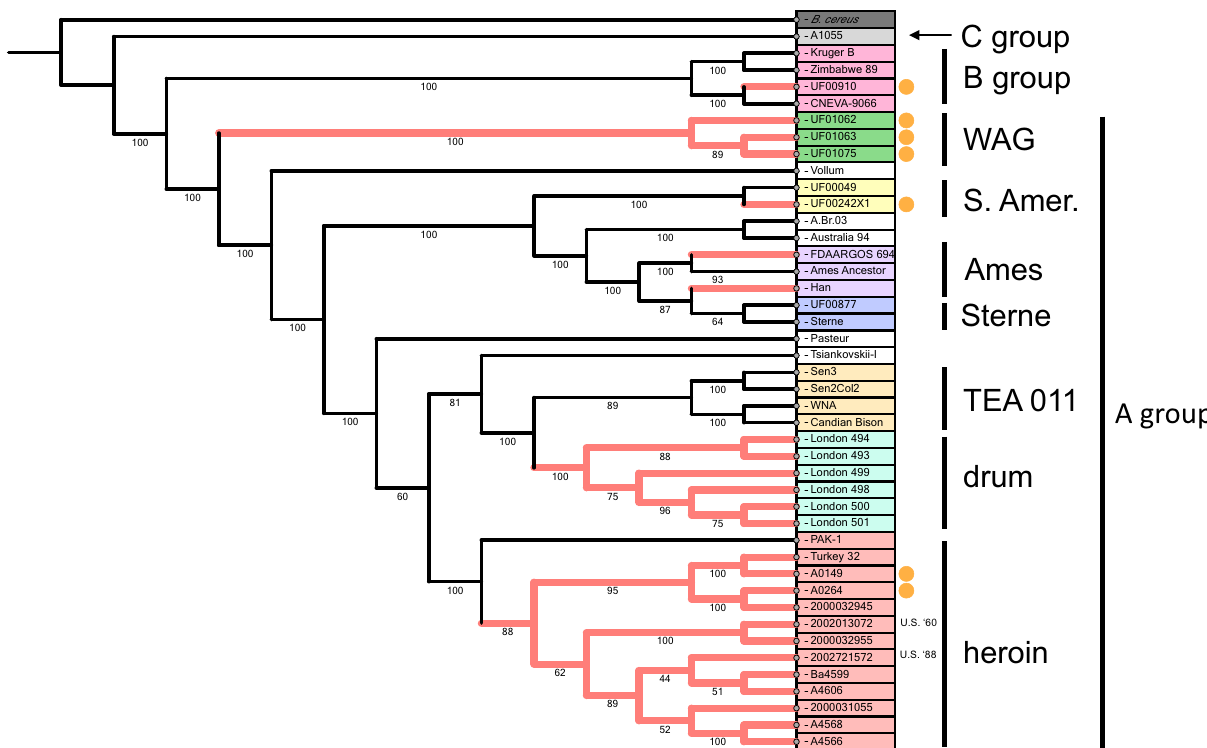
Figure 1. Whole genome SNP tree of known ant - Bacillus anthracis strains in relation to other B. anthracis lineages. Various B. anthracis groups and lineages of interest to this work are labeled on the right side of the figure. The orange dots indicate strains in our collection that are anthrose negative. The different colored labels are to help differentiate the lineages. The red highlighted branch labels indicate B. anthracis strains that are anthrose negative by whole genome sequence interrogation. B. cereus is natively anthrose negative, not because of discreet mutations, and so the branch is not highlighted red. The branch lengths are indicated above the branches with bootstrap values out of 100 located underneath. The tree has been rooted to the B. cereus outgroup. Diverse strains across lineages are acquiring anthrose negativity in diverse and independent ways. The whole genome SNP phylogenetic tree in this figure was produced by analysis with PhaME 54 and visualized with iTOL 55 .